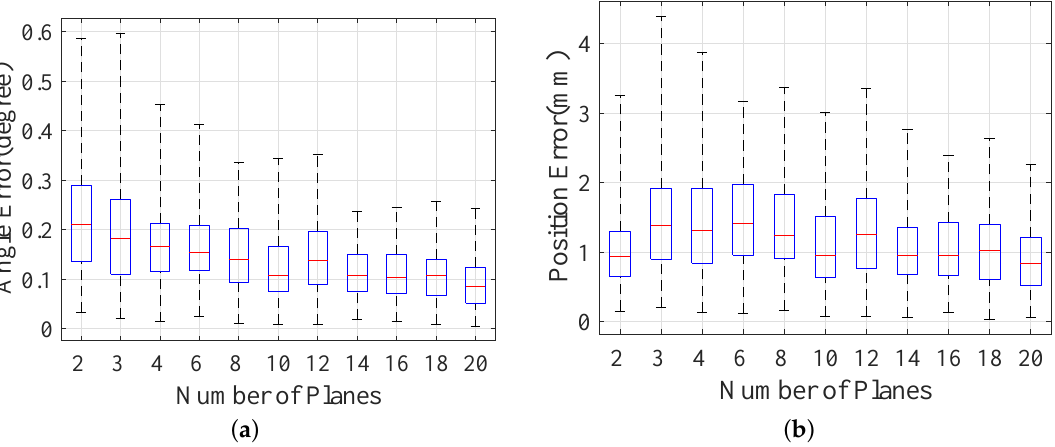
Figure 5. Error distribution under different numbers of poses in the range of [2, 20]: ( a ) angular error of direction; ( b ) position